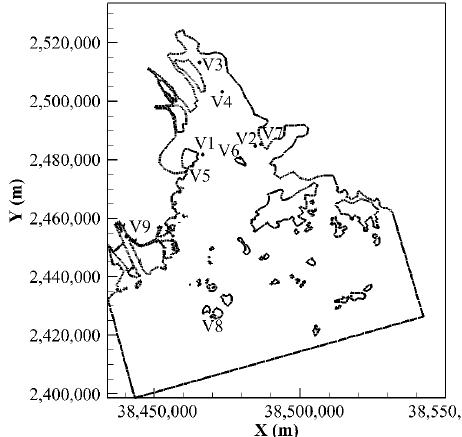
Figure 4. The spatial distribution of measuring points V1–V9.